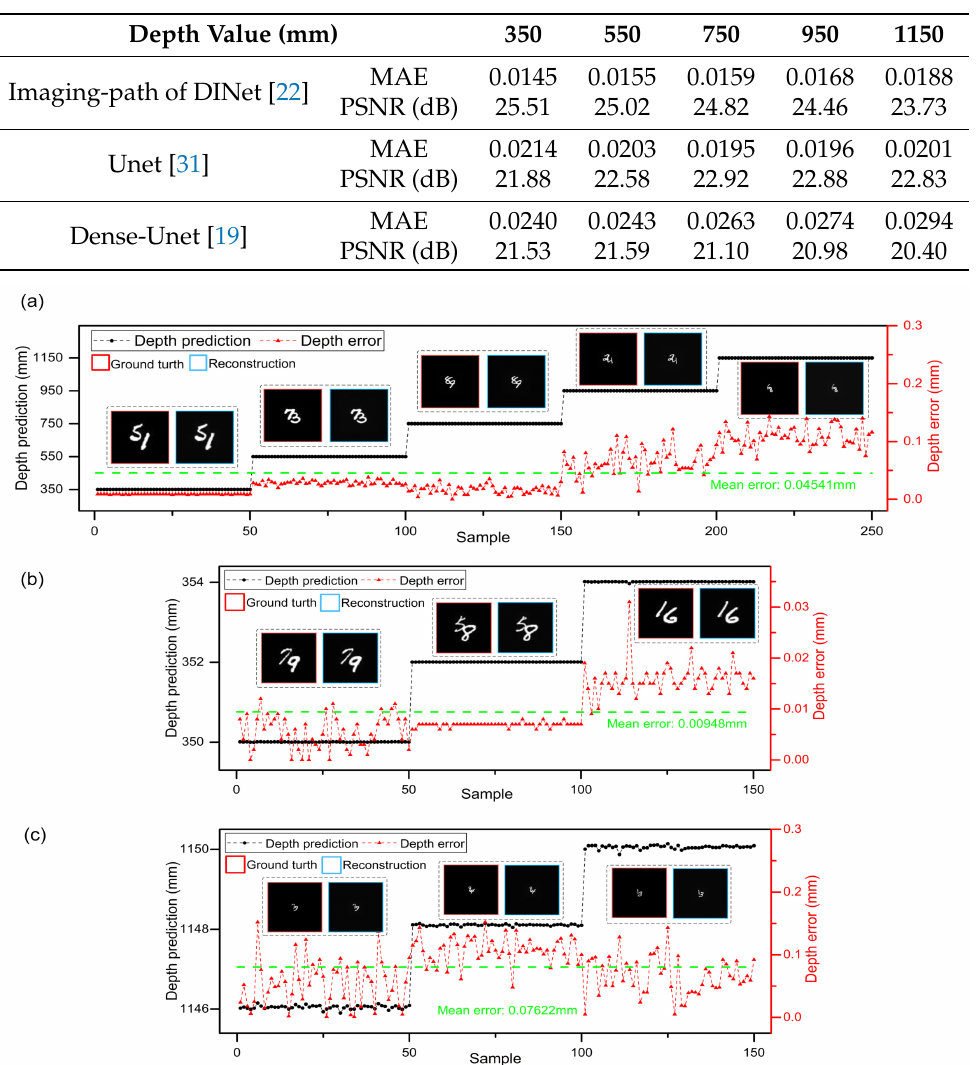
Table 1. Quantitative evaluation of reconstruction each position.